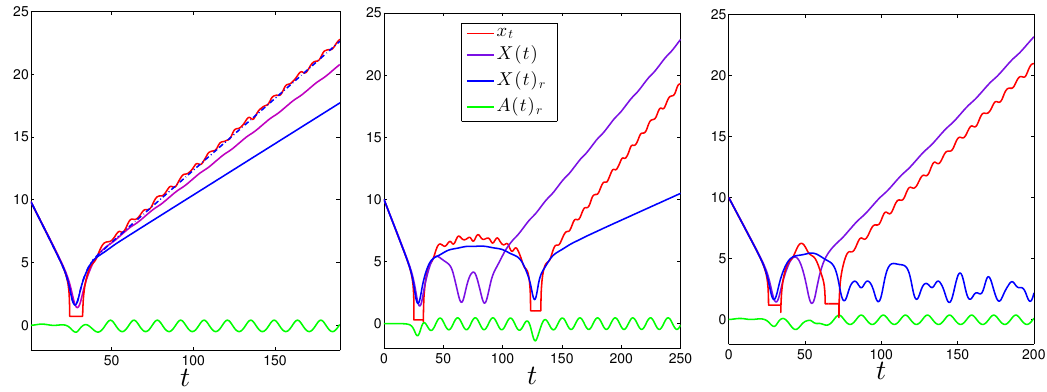
Figure 10 . Effect of shape mode(s) and (multi-)bounce windows for ǫ = 0 . 5, q = 0 . 6196, v in = 0 . 26 (left), v in = 0 . 24771 (middle), v in = 0 . 2372 (right). In each panel, the curves represent the position of kink’s center versus time obtained from: PDE (red), full-ODE (purple), reduced-ODE (blue), and the amplitude of the internal mode for the reduced-ODE (green). The blue dashed curve (left) corresponds to the reduced-ODE model with q perturbing to be 0 . 6155 in order to obtain a better